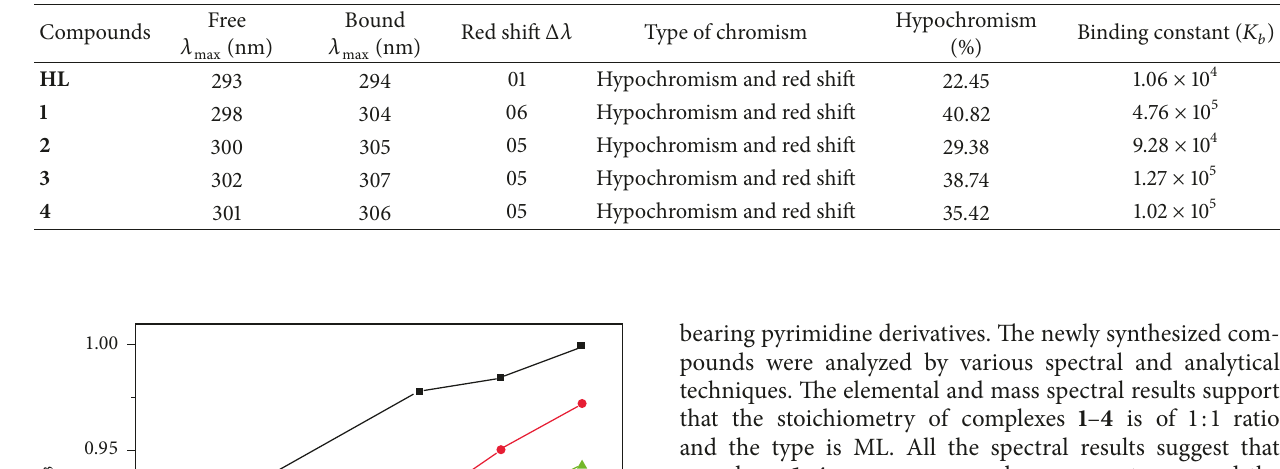
Table 6: Absorption spectral properties of HL and complexes 1 – 4 with CT-DNA.